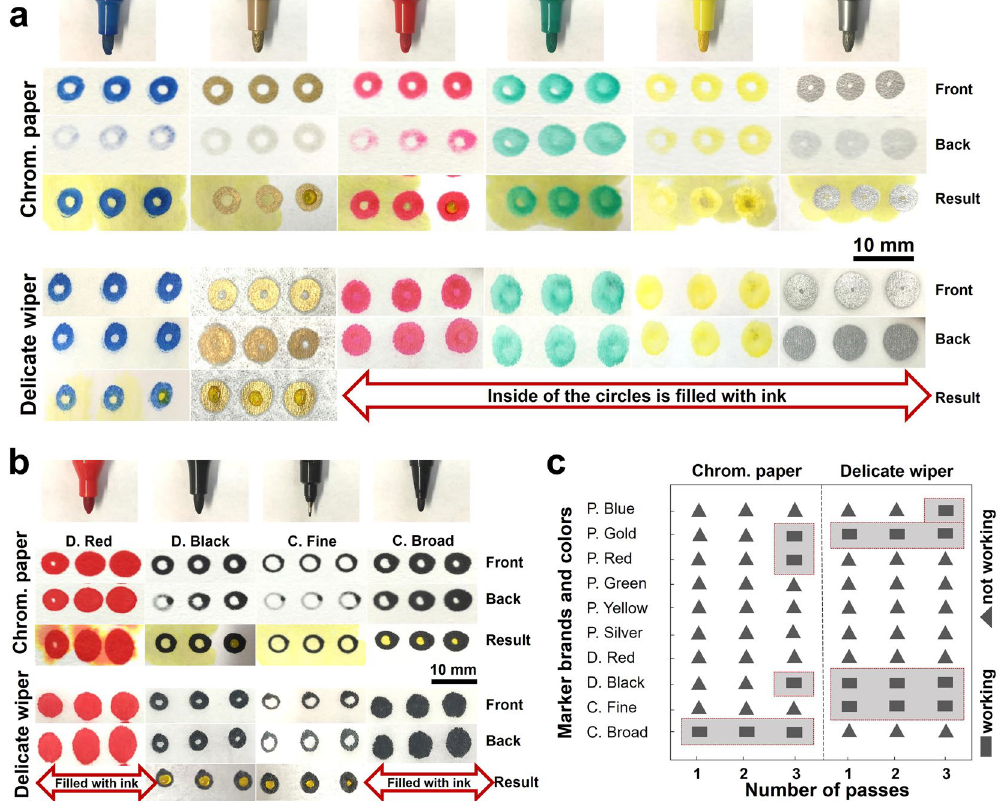
Figure 2. The water-resistant capability of markers. ( a ) Images of plotted patterns with Sipa markers with different colors on chromatography papers and delicate task wipers. From top to bottom, images were arranged to show the front and the back of the papers (with only inks), and results by spotting yellow aqueous food dye. ( b ) Images of plotted patterns with Deli and Comix markers on chromatography papers and delicate task wipers. ( c ) Performance chart for different markers and papers for single and multiple passes. Diameter of the circles is 4